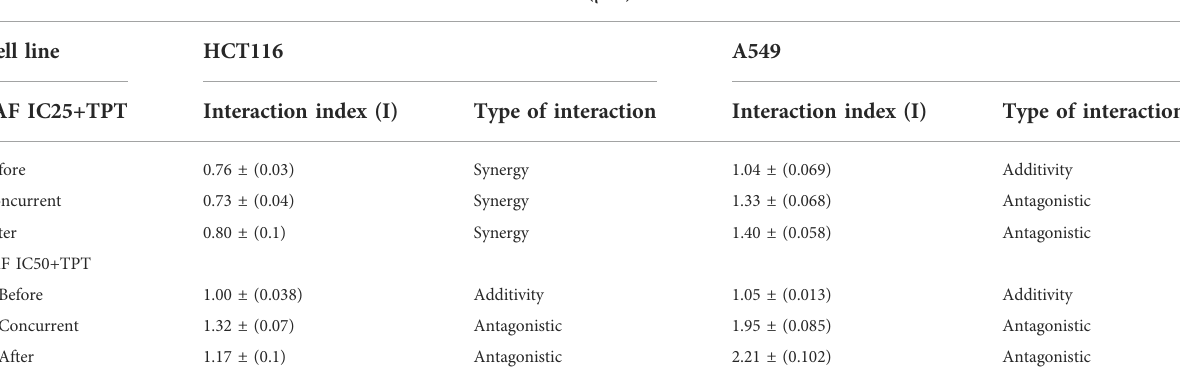
TABLE2EffectofSAFonTPTcytotoxicity inHCT116andA549cellsandthetype ofinteractionaftereachtreatmentandsequence.Interactionindex: I =d1/D1+d2/D2,whered1andd2aretherespective concentrationsofTPTandSAFused inthecombination required toproducea fi xedlevelof inhibition IC25/IC50. While D1 and D2 represent concentrations of each TPT and SAF alone to produce the same magnitude of effect (IC25/IC50). Values presented are means ± SEM of at least three independent